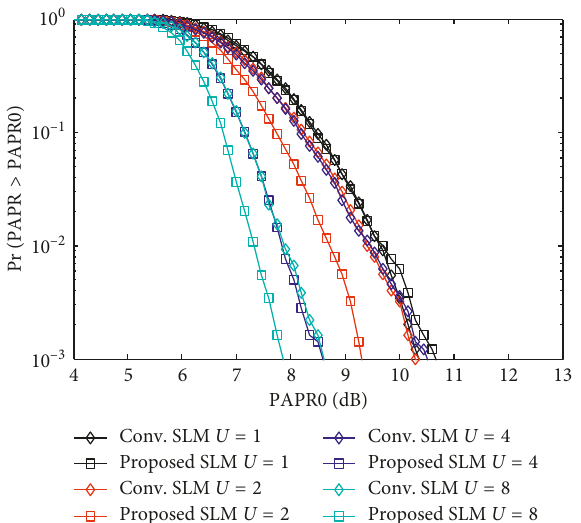
Figure 9: Comparison of SLM given in [5] with the proposed SLM for U � 1, 2, 4, and 8, N � 128, and 4-PSK.